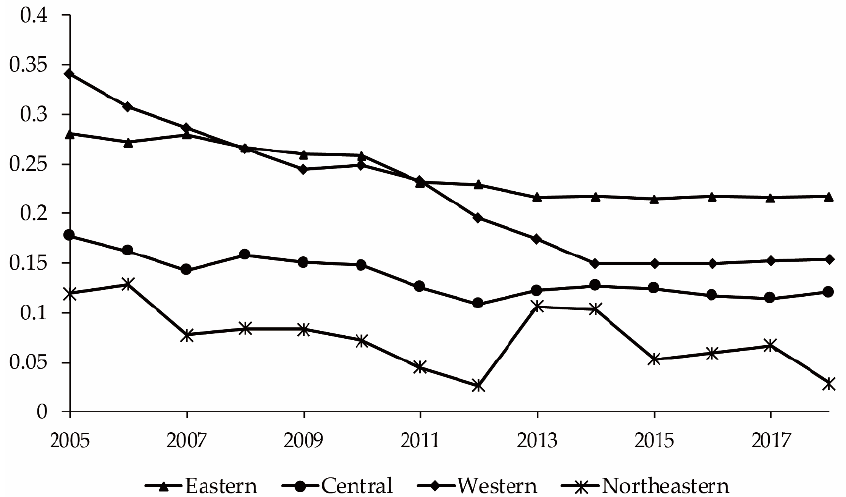
Figure 5. The change of σ -convergence coefficient of DVI in China.